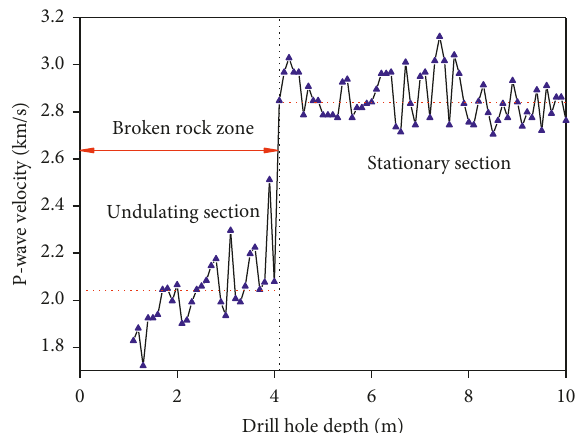
Figure 6: The relationship between the wave velocity and the depth of the drilling hole of the test point